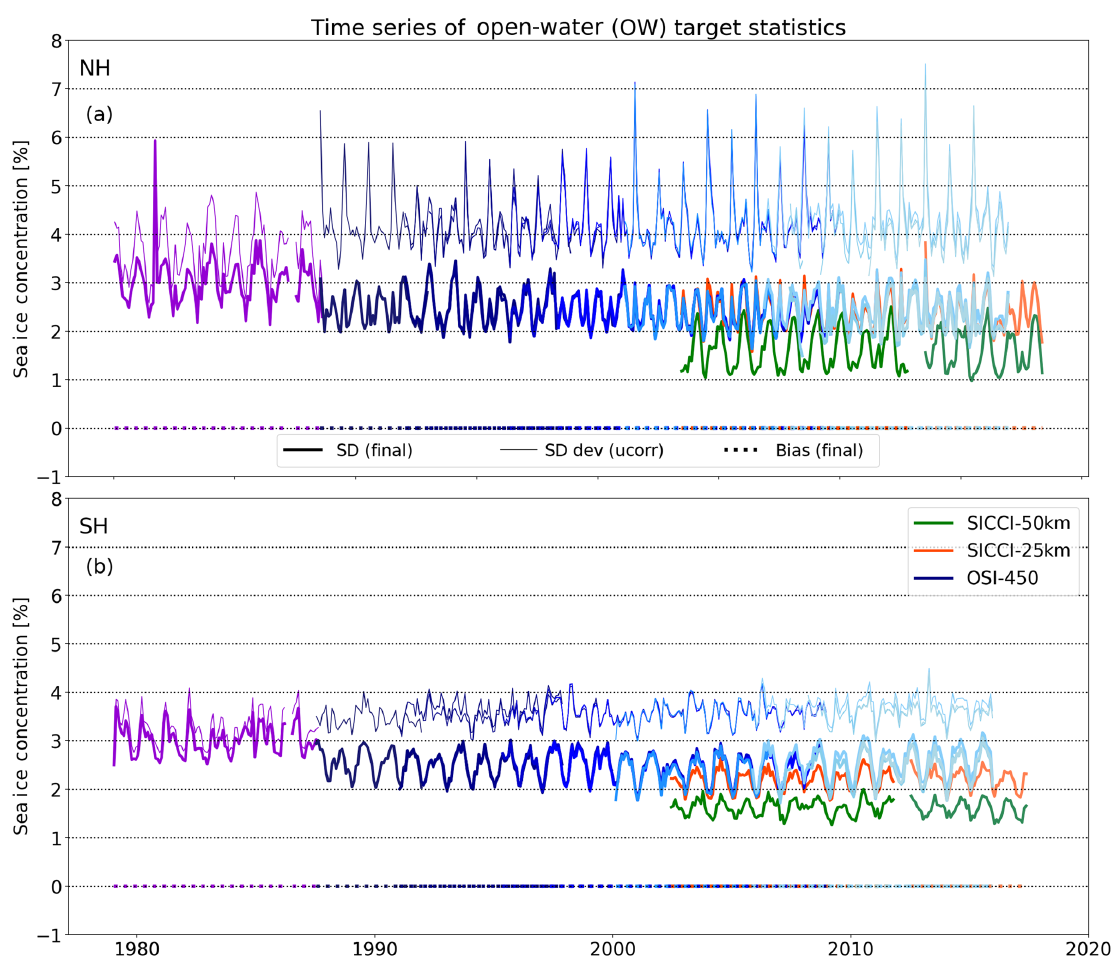
Figure 8. Time series of performance statistics for the three CDRs (blue: OSI-450, red: SICCI-25km, green: SICCI-50km) over the open- water target for the Northern Hemisphere (a) and Southern Hemisphere (b) . For OSI-450 and SICCI-25km, the colour of the lines is for individual satellites, as used in Fig. 1. For OSI-450, the thick (thin) solid lines plot the OW standard deviation of SIC (SIC ucorr ). The thin solid lines are only plotted for OSI-450 so as not to clutter the plot area. The bias of SIC is plotted with a dotted